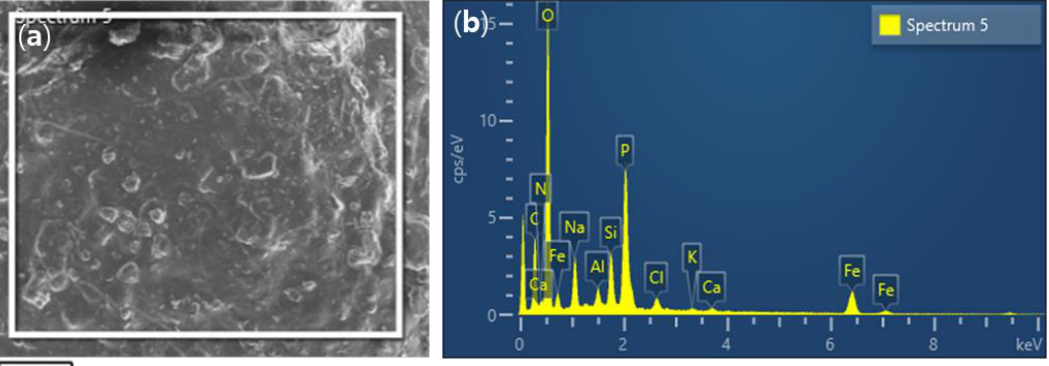
Figure 4. Images of ( a ) SEM and ( b ) EDS spectra of the SCM beads.